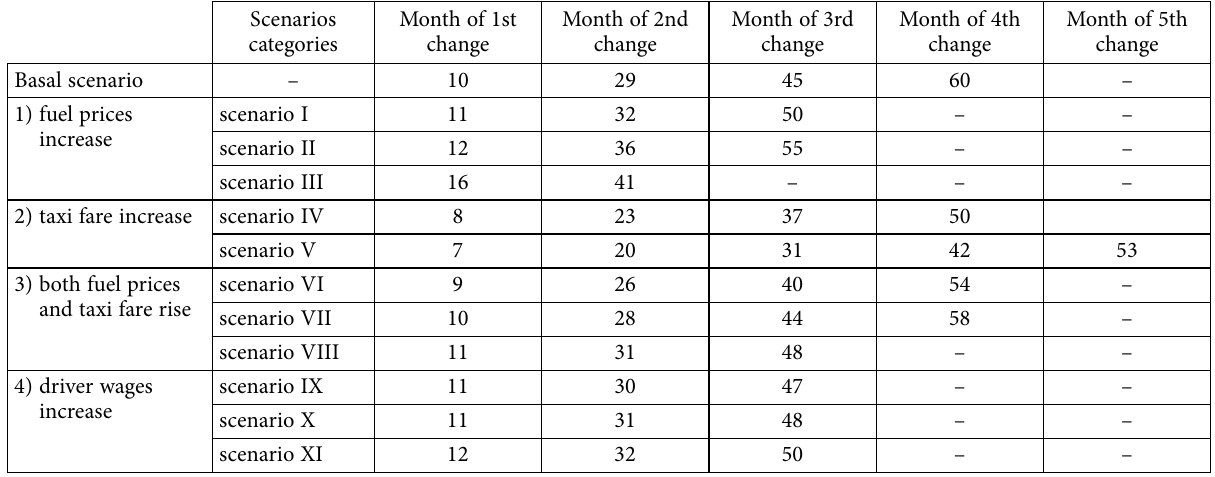
Table A1. The statistics of time node changes for taxi operation simulation